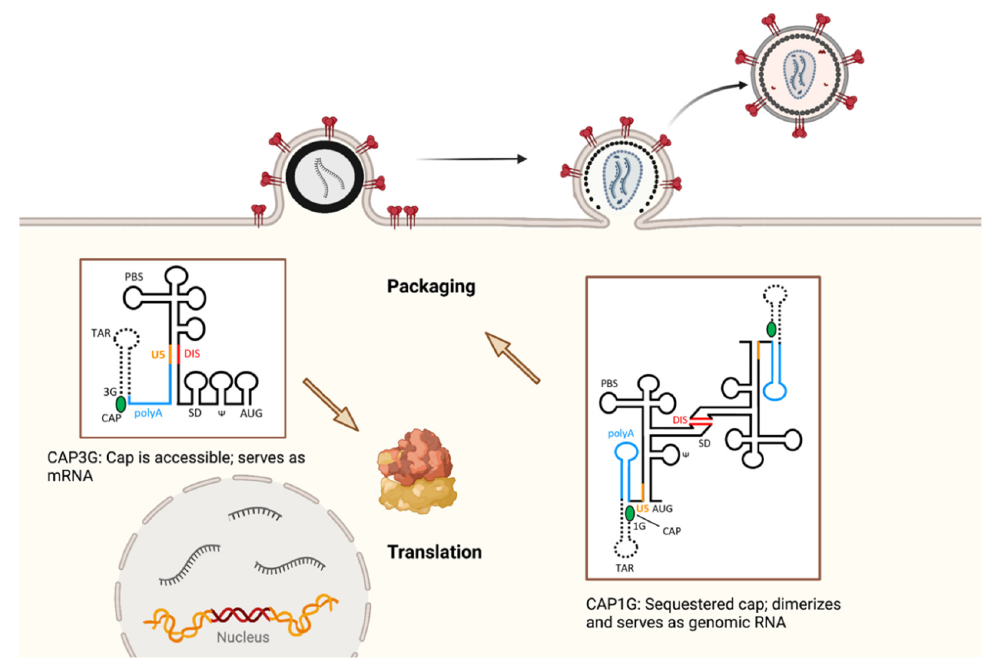
Figure 2. Selection of gRNA for packaging versus use as mRNA for translation. Note that in the CAP3G RNA, the 5 ′ cap is accessible and the RNA is monomeric, while in the CAP1G form the 5 ′ cap is sequestered and RNA dimerizes for packaging. RNA structure schematics modeled from [28]. DIS = dimer initiation site; SD = major splice donor; PBS = primer binding site. Figure adapted from HIV Replication Cycle by BioRender.com (2022).